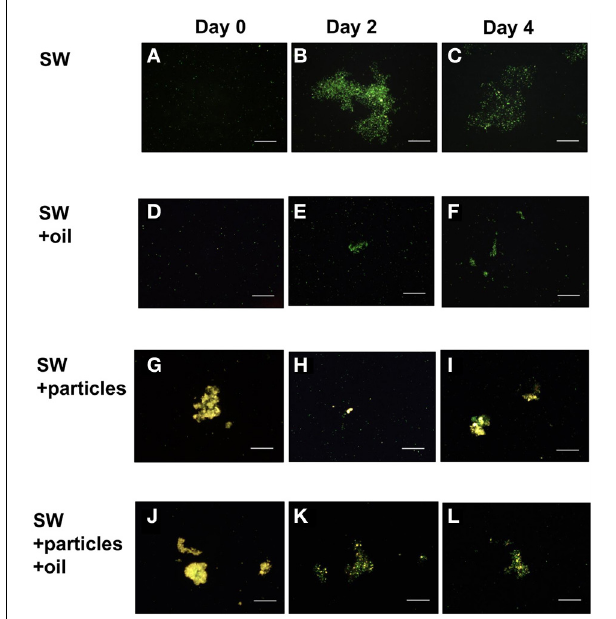
FIGURE 3 | Bacterial micro-aggregates in GOE. Epilfluorescence microscopy of untreated tank water samples at days 0 (A,D,G,J) , 2 (B,E,H,K) , and 4 (C,F,I,L) reveal the development of bacterial micro-aggregates in the absence of oil at days 2 (B) and 4 (C) . Tank water samples amended with GCS-oil lack micro-aggregates. All micrographs were imaged at 200 × magnification, and scale bars are 50 μ m.